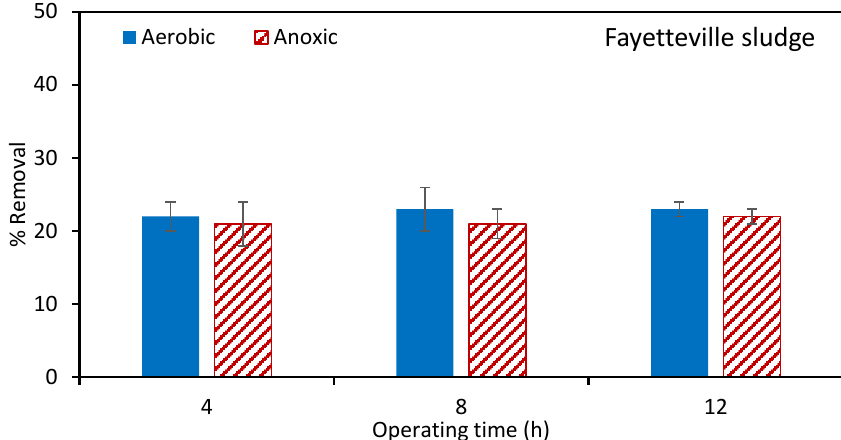
Figure 5. Percentage of atrazine removal using Fayetteville sludge. The initial atrazine concentration was 1 ppm. The total suspended solids (TSS) for aerobic and anoxic tanks was 6383 and 5023 ± 600 mg/L, respectively.